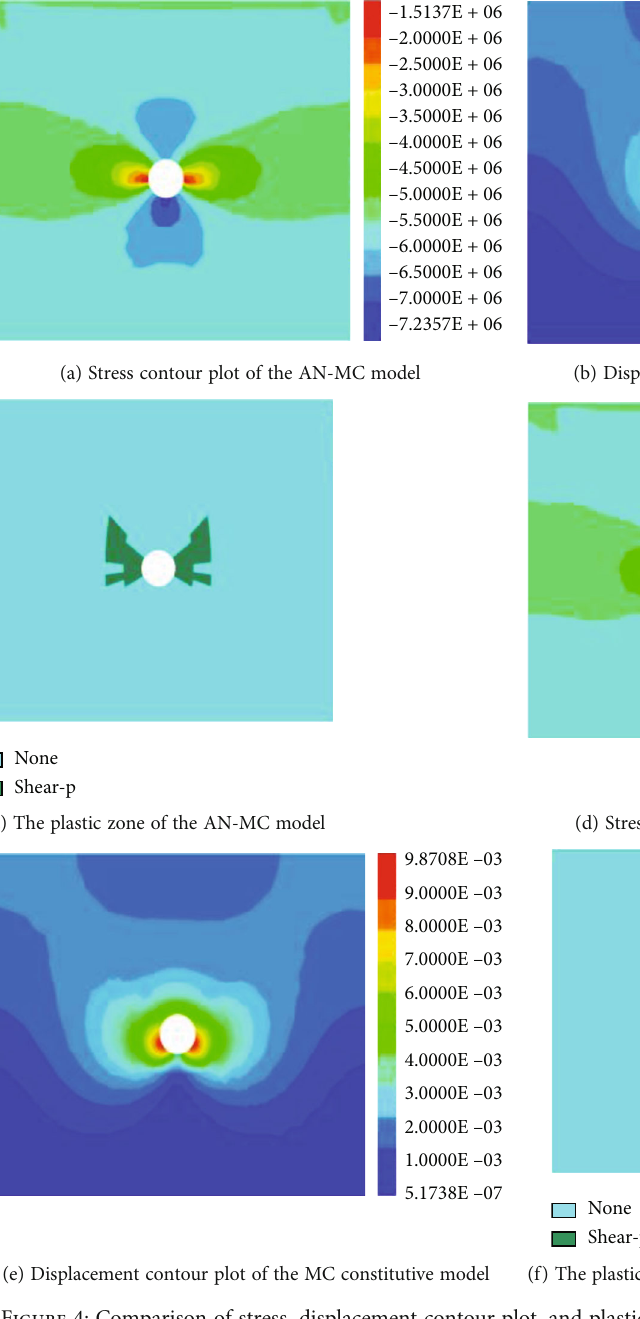
Figure 4: Comparison of stress, displacement contour plot, and plastic zone under di ff erent constitutive